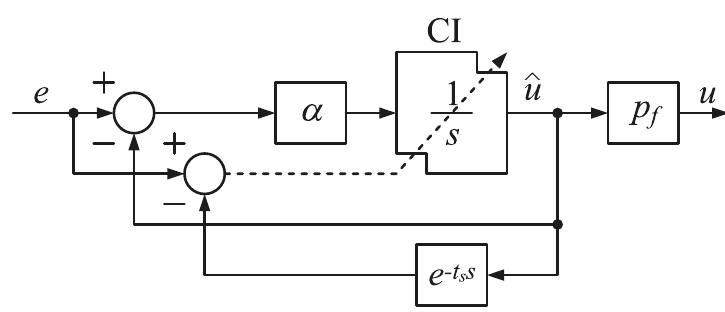
Figure 2. Block diagram of modified FORE, where e ‐ tss is the unit delay.